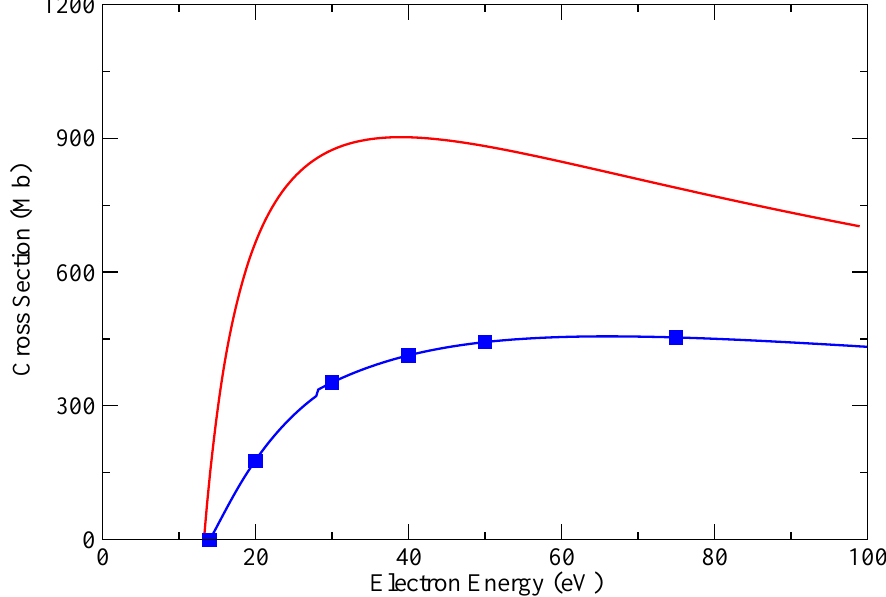
Figure 1. Electron ionization of the 4 p subshell of Kr Solid line (red): distorted-wave method, solid line with squares (blue): time-dependent close-coupling method (1.0 Mb = 1.0 × 10 − 18 cm 2 ).